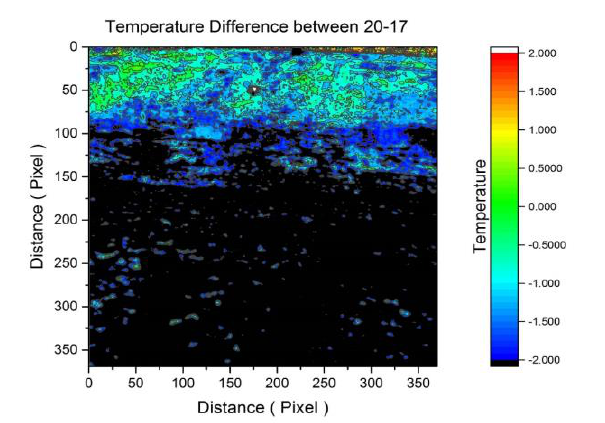
Figure 3 (c) Temparature diference between